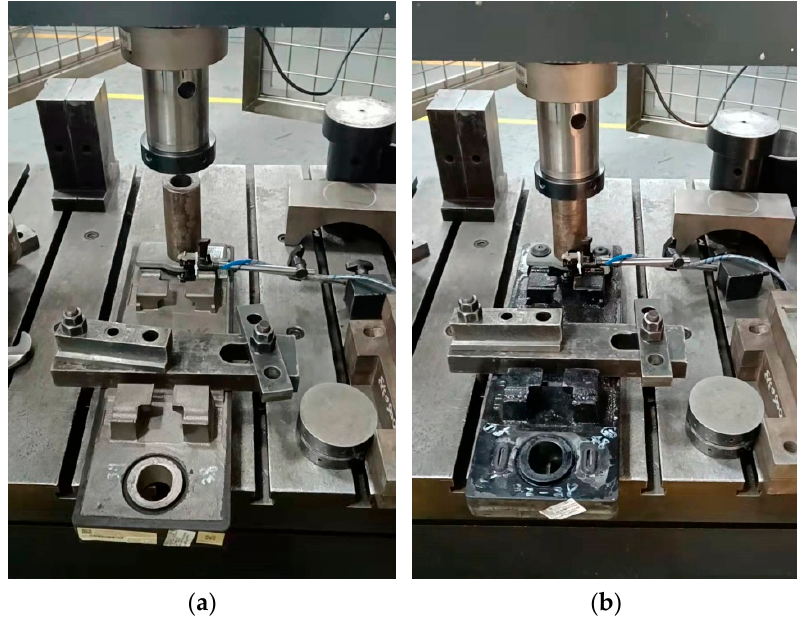
Figure 7. Elastic iron tie plate precompression test under Experimental conditions ( a ) 5 and ( b ) 6.